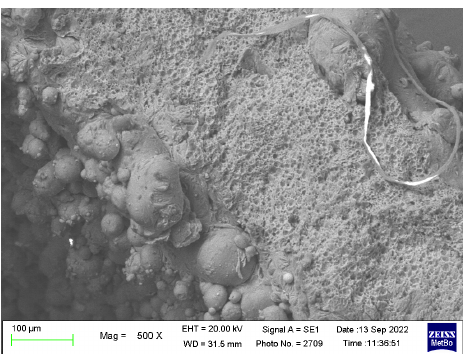
Figure 11. Final fracture surface of a 0.6 mm thick specimen T6 treated.